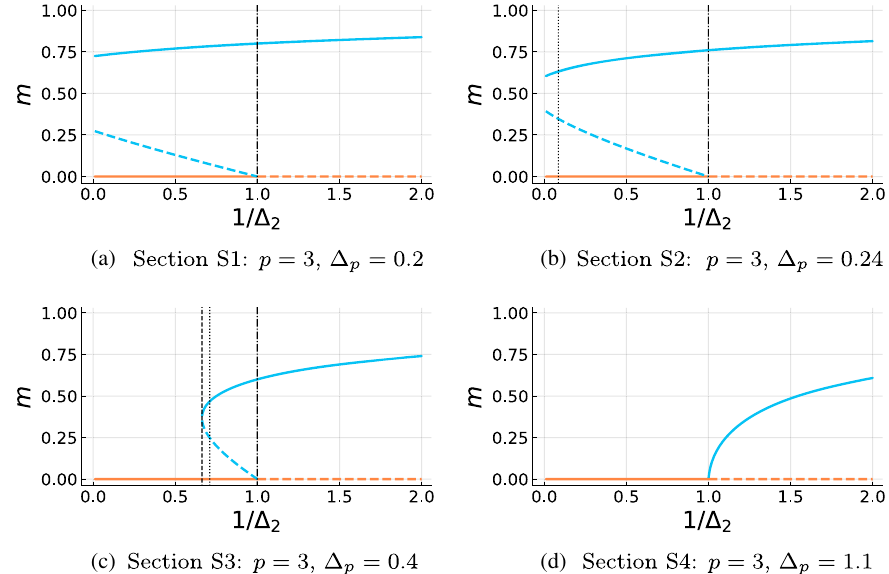
FIG. 9. Fixed points of Eq. (B37) as a function of Δ 2 for p ¼ 3 and several fixed values of Δ to the vertical cuts in the left panel of Fig. 7. Solid lines are stable fixed points; dashed lines are unstable fixed points. The blue line represents informative fixed points with positive overlap with the signal, while the orange line represents uninformative fixed points with no overlap with the signal. Starting from high Δ 2 , an informative fixed point appears at the dynamical threshold (vertical dashed line) but is energetically disfavored until it reaches the information-theoretic threshold (vertical dotted line); finally, it becomes the only stable solution crossing the algorithmic threshold (vertical dotted-dashed line). When the transi- tion is continuous, the three vertical threshold lines merge, and we have a single second-order phase transition, which occurs here ≥ 1 . at Δ p